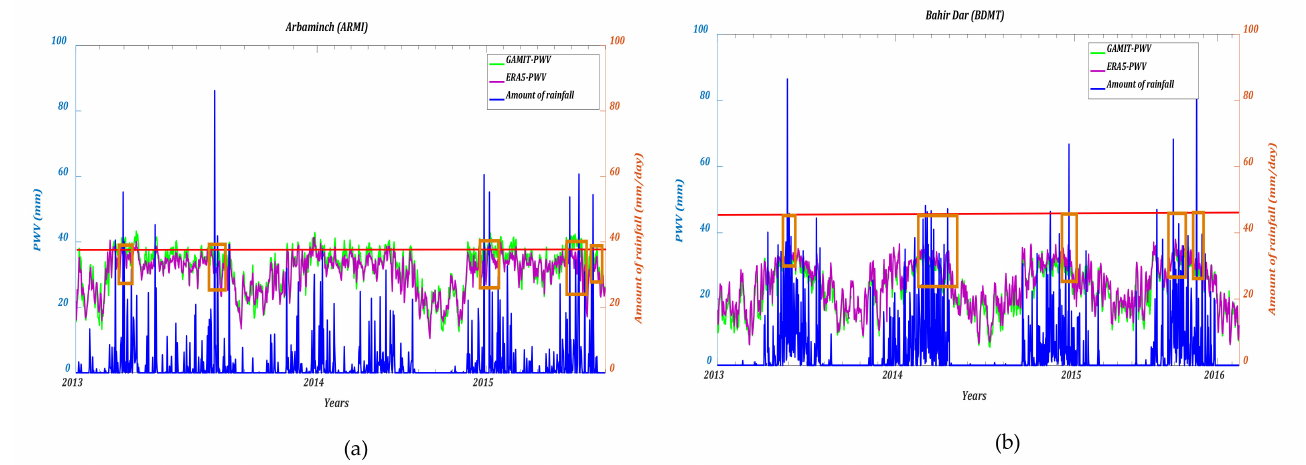
Figure 6. Time series of GAMIT-PWV, ERA5-PWV and amount of rainfall for the stations ( a ) ARMI and ( b ) BDMT. The horizontal red line shows the threshold value we determined for the heavy rainfall events and the orange rectangle shows that PWV values are maximum during heavy rain